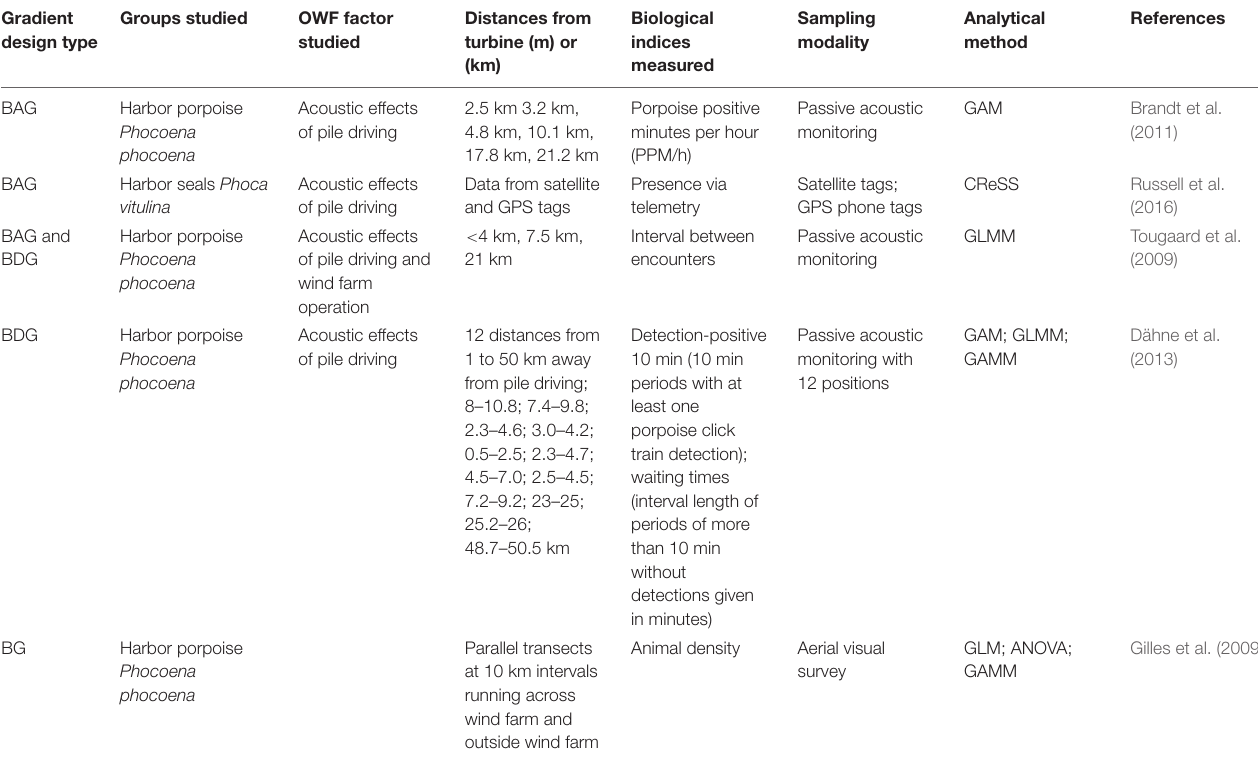
TABLE 4 | Studies of marine mammals that used a gradient design to examine the effects of OWF development. Gradient Groups design type